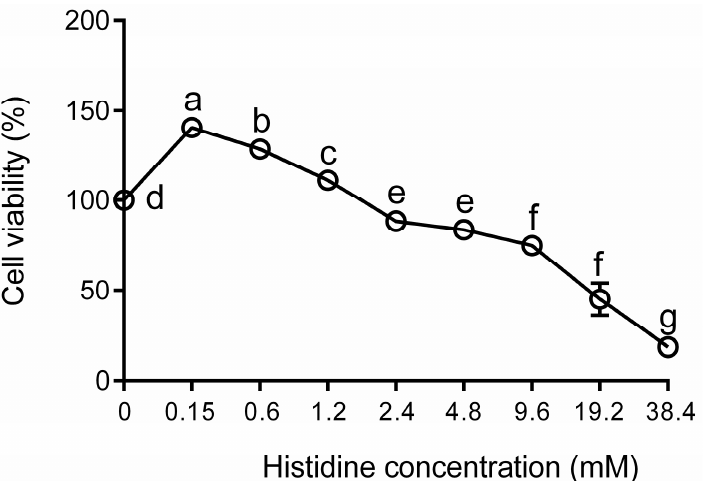
Figure 1. The effects of His on bovine hepatocytes. The bovine hepatocytes were incubated with 0 (control group), 0.15, 0.6, 1.2, 2.4, 4.8, 9.6, 19.2, and 38.4 mM His for 24 h. Data are presented as the means ± SEM ( n = 6). Means at the different concentration of His with different letters (a–g) differ significantly for treatment effect.